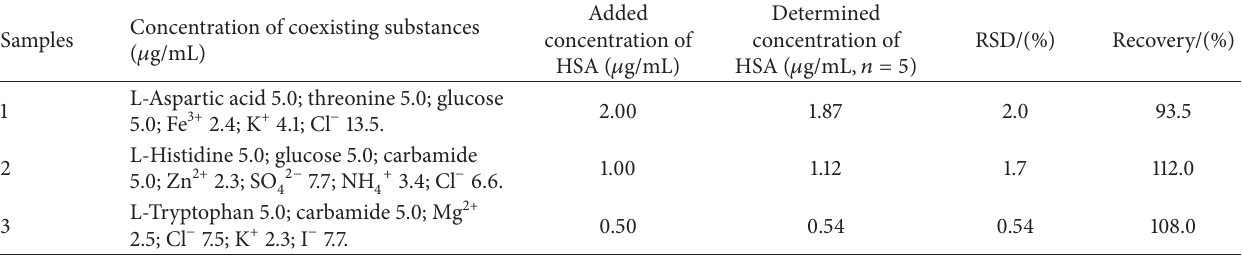
Table 3: Results of the determination of proteins in synthesized samples using the RRS method.